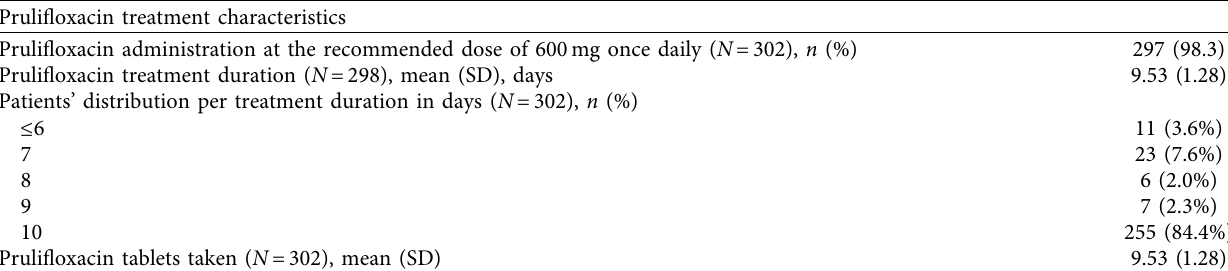
Table 2: Prulifloxacin treatment characteristics.